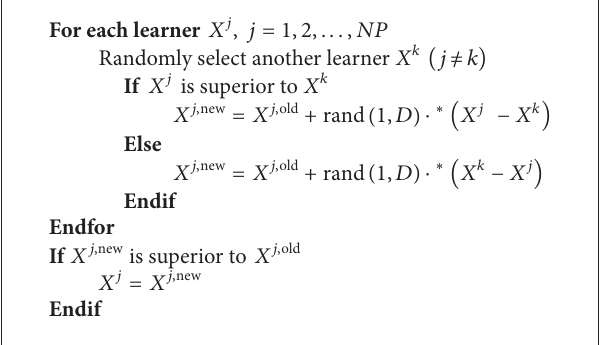
Algorithm 6: The procedure of learner